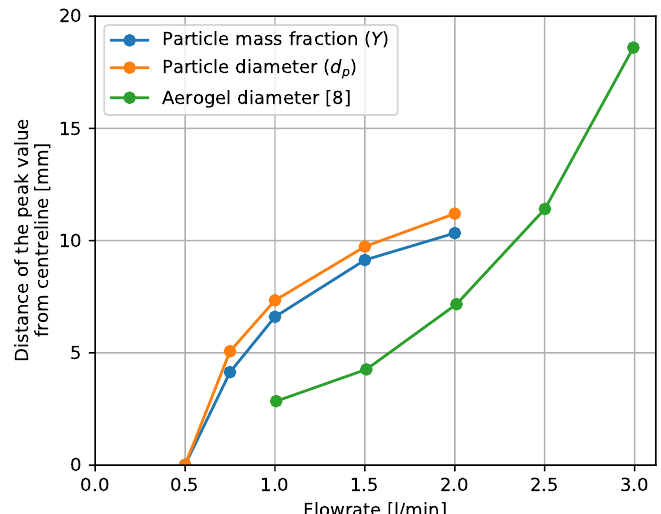
Figure 9. Radial location of the peak values of particle mass fraction and particle diameter as a function of flowrate, at a peak temperature of 1250 ◦ C and ferrocene mass fraction of 0.5mass%. The experimentally measured aerogel diameter from Conroy et al. [8] are included. The aerogel measurements are for a reactor with a larger diameter and a process that uses a different ferrocene mass fraction.